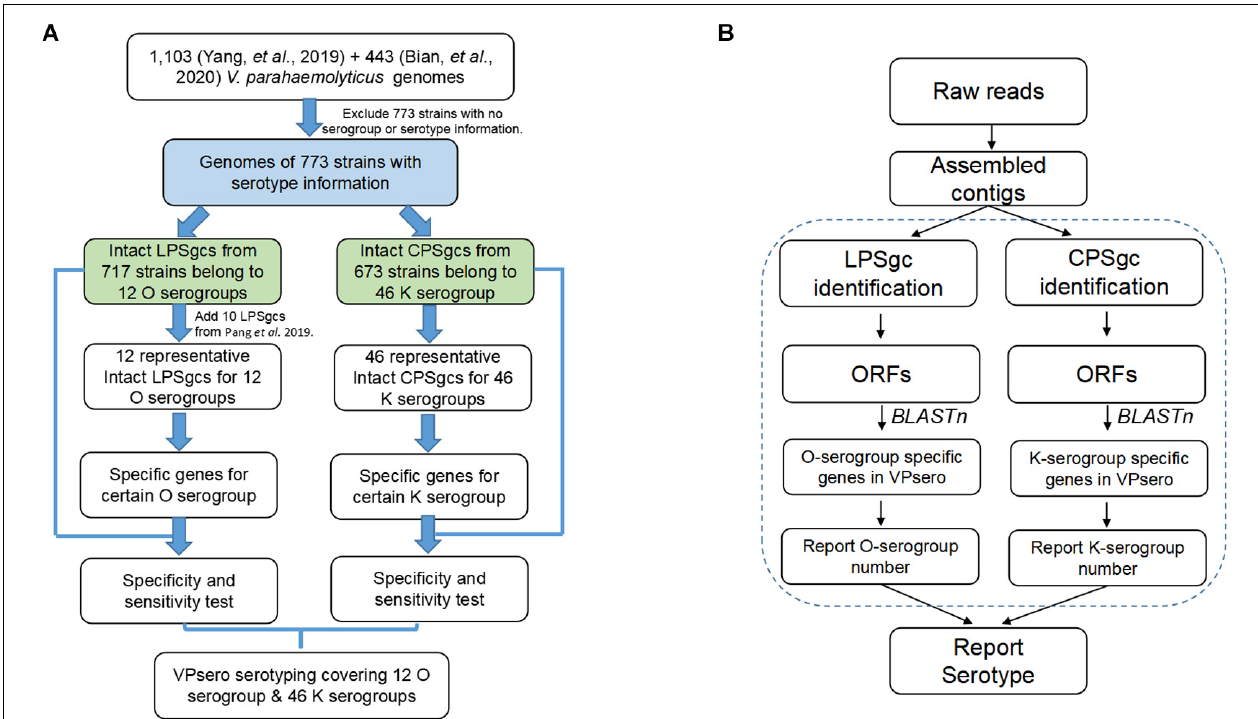
FIGURE 1 | Flowchart outlining (A) development process of VPsero and (B) algorithm of